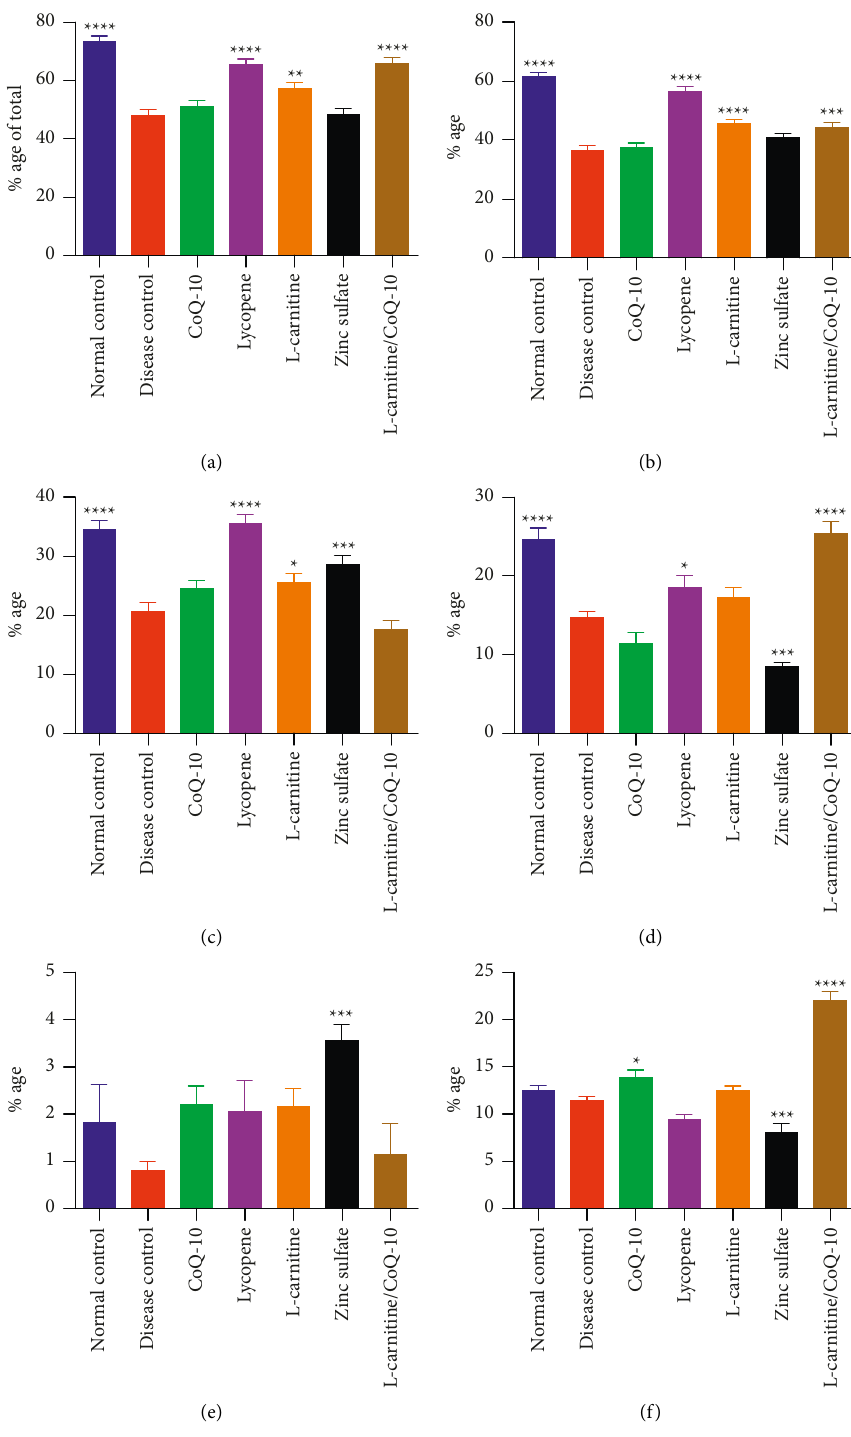
Figure 2: Effect of lycopene, L-carnitine, coenzyme Q10, and zinc sulfate on sperm motility of cadmium-exposed rats. Results presented as mean ± S.D.( n � 10). ∗∗∗∗ , ∗∗∗ , ∗∗ and ∗ showed statisticallysignificant as compared to diseasedcontrol at P < 0.0001, 0.001,0.01and 0.05 respectively.